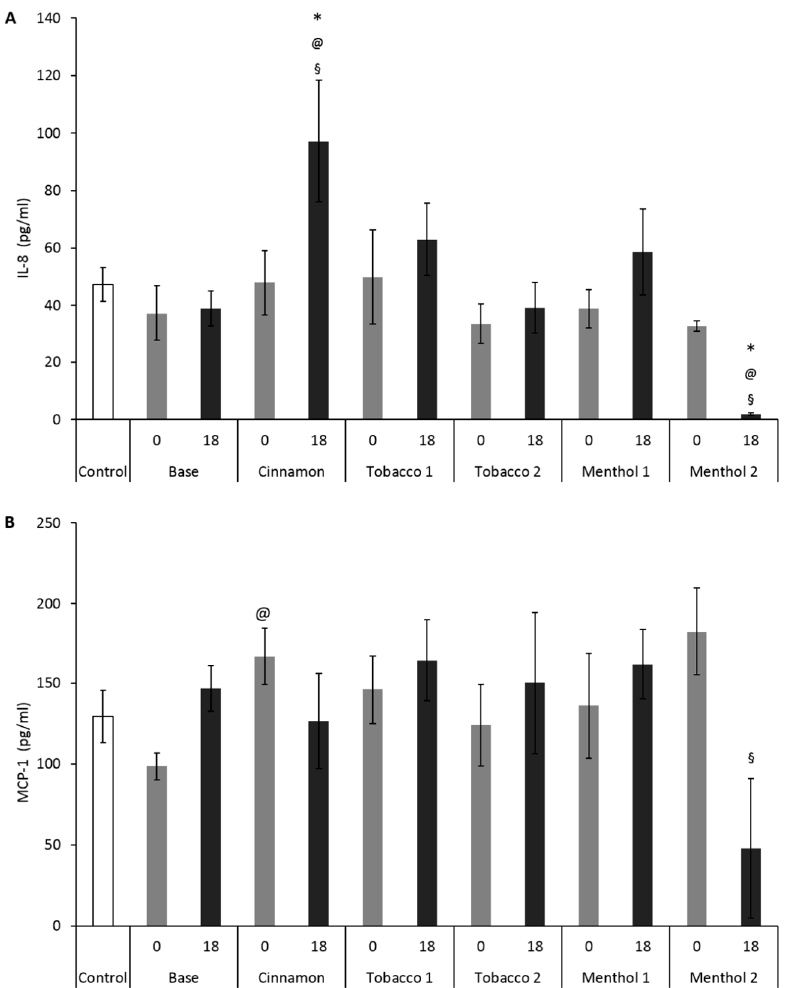
Figure 3. Pro-inflammatory cytokines released by monoculture A549 cells exposed to CAs from e-liquid samples with (18 mg/mL, black bars ) and without ( grey bars ) nicotine; white bars represent control samples. ( A ), IL-8 release; ( B ), MCP-1 release. Bars represent the concentration (pg/mL) of the released protein. Data are presented as mean ± SEM of at least five different independent experiments. * p < 0.05; unpaired t -test over the control; @ p < 0.05; unpaired t -test over Base 0; § p < 0.05; unpaired t -test over Base 18.